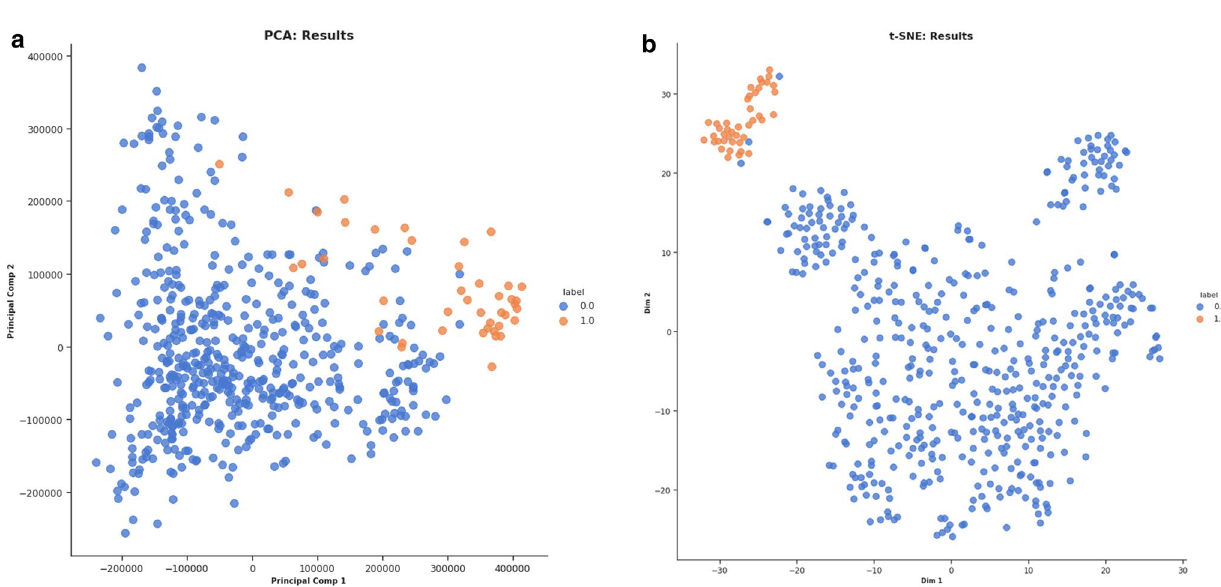
Figure 3. Dimensionality reduction analysis for CRC dataset. ( a ) PCA analysis. ( b ) t-SNE analysis. 0 stands for CRC tissue samples while 1 stands for normal tissue